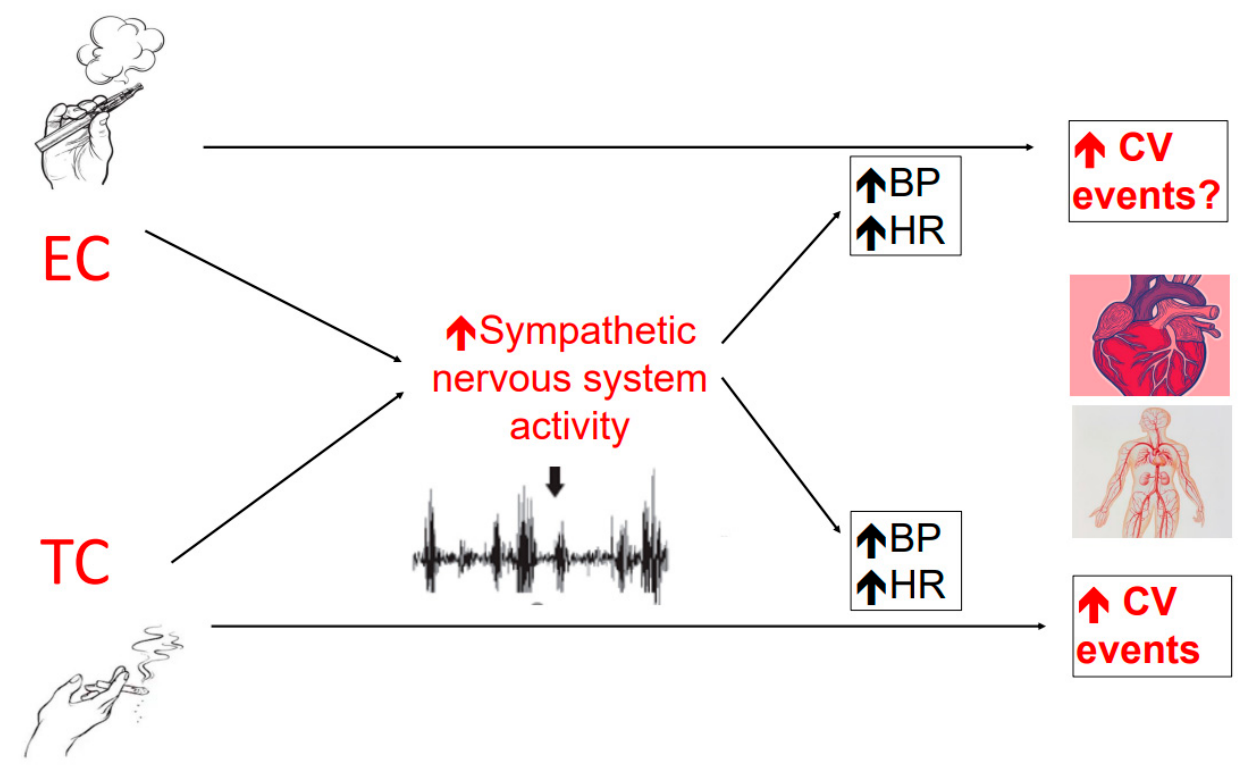
Figure 6: EC smoking, similar to TC smoking, may act at a central level to cause a uniform increase in sympathetic nerve traffic to blood vessels, skin and the heart. Alterations in sympathetic drive are paralleled by an increase in blood pressure and heart rate, reflecting a systemic hemodynamic response to smoking of both types of cigarettes. These unfavorable effects of ECs mimicking those by TCs may chronically lead to increased risk of cardiovascular events. BP, blood pressure; CV, cardiovascular; EC, electronic cigarette; HR, heart rate; TC, tobacco cigarette. cardiovascular; EC, electronic cigarette; HR, heart rate; TC, tobacco